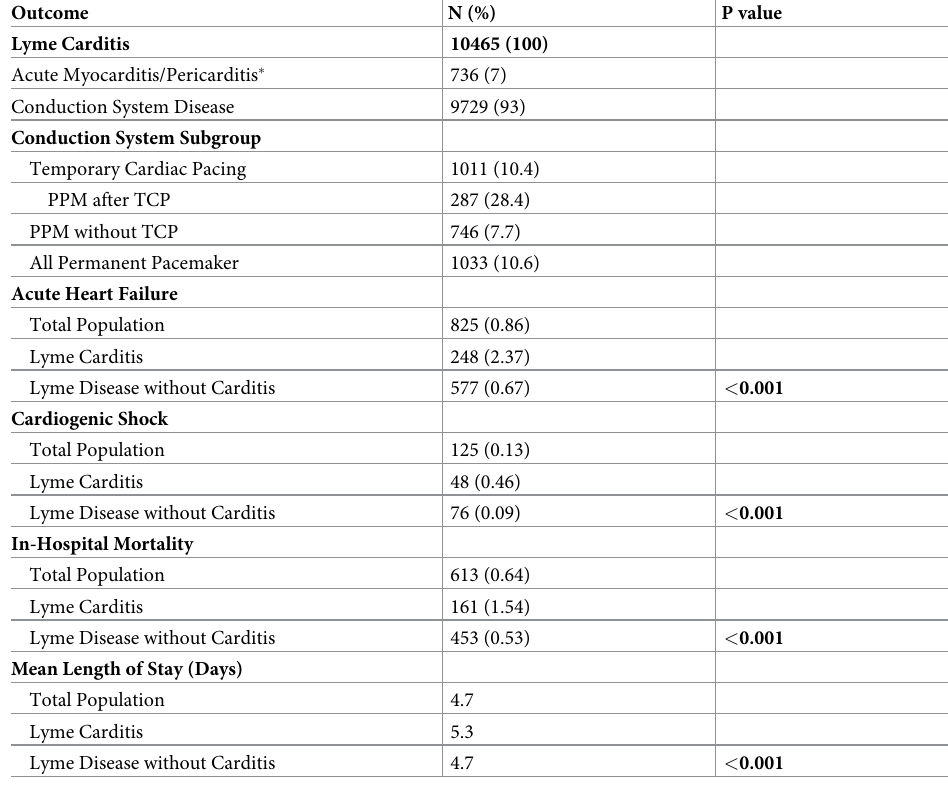
Table 5. Outcomes in patients hospitalized with Lyme carditis. Outcome N (%) P value Lyme Carditis 10465